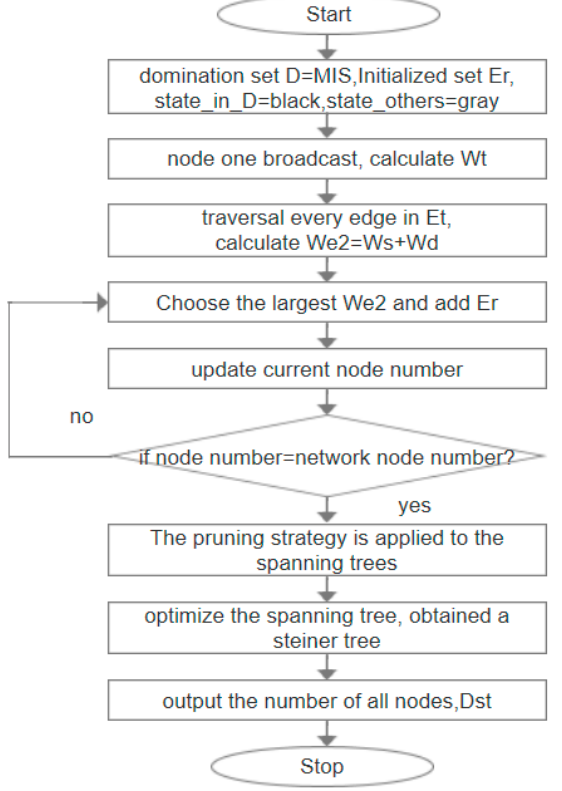
Figure 6. Flowchart of ML-ST algorithm.